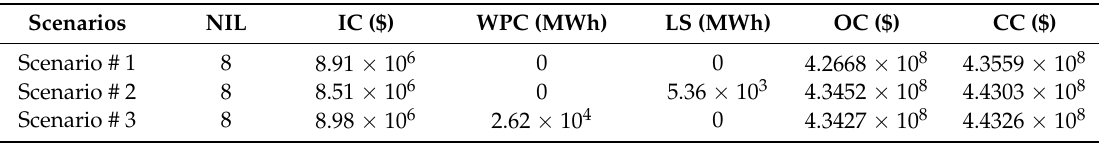
Table 3. RTEP results obtained under different wind farm